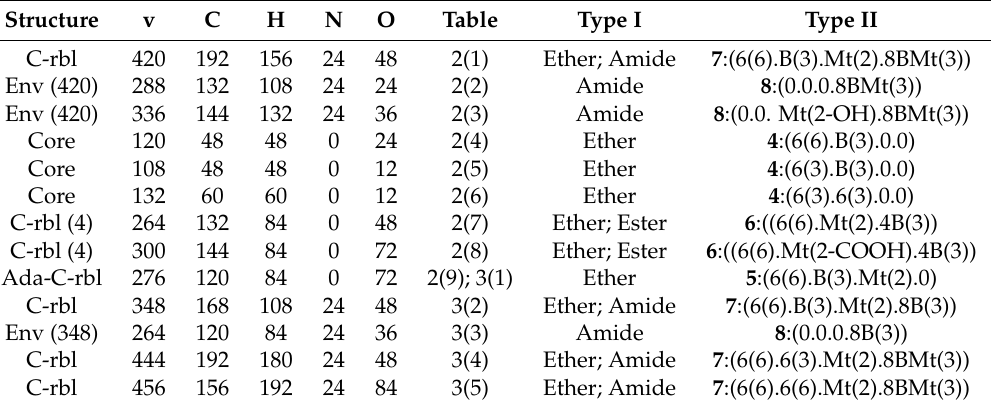
Table 1. Cube-rhombellanes: structure; v = no. vertices/atoms; type.